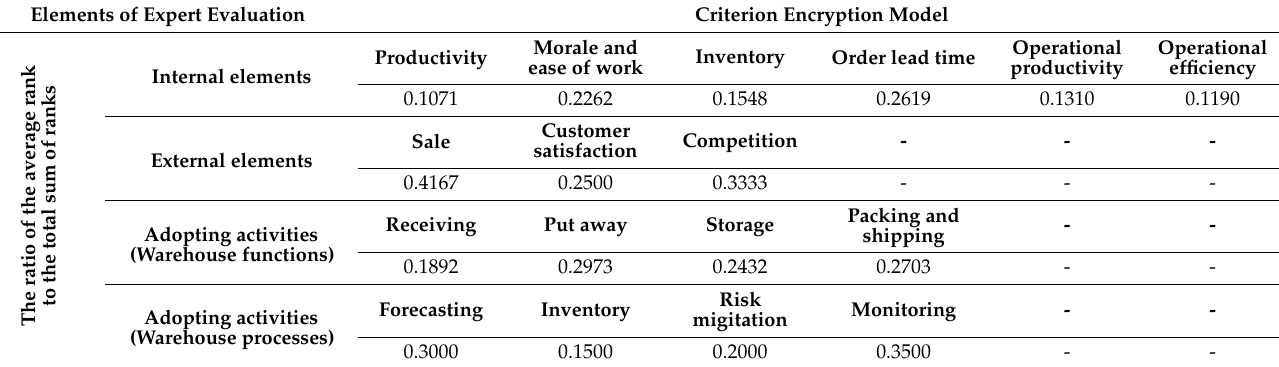
Table 12. The results of the ratio of the average rank to the total sum of ranks.